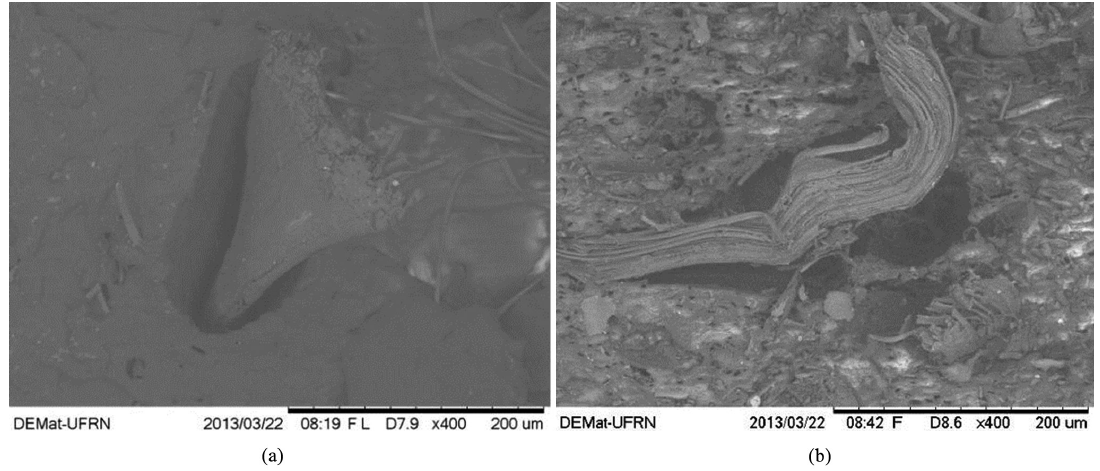
Figure 2. Scanning electron microscopy of (a) 5% PP/Curaua and (b) 20% Table 2. Mechanical properties of polypropylene and the biocomposite obtained in the tensile test. Material